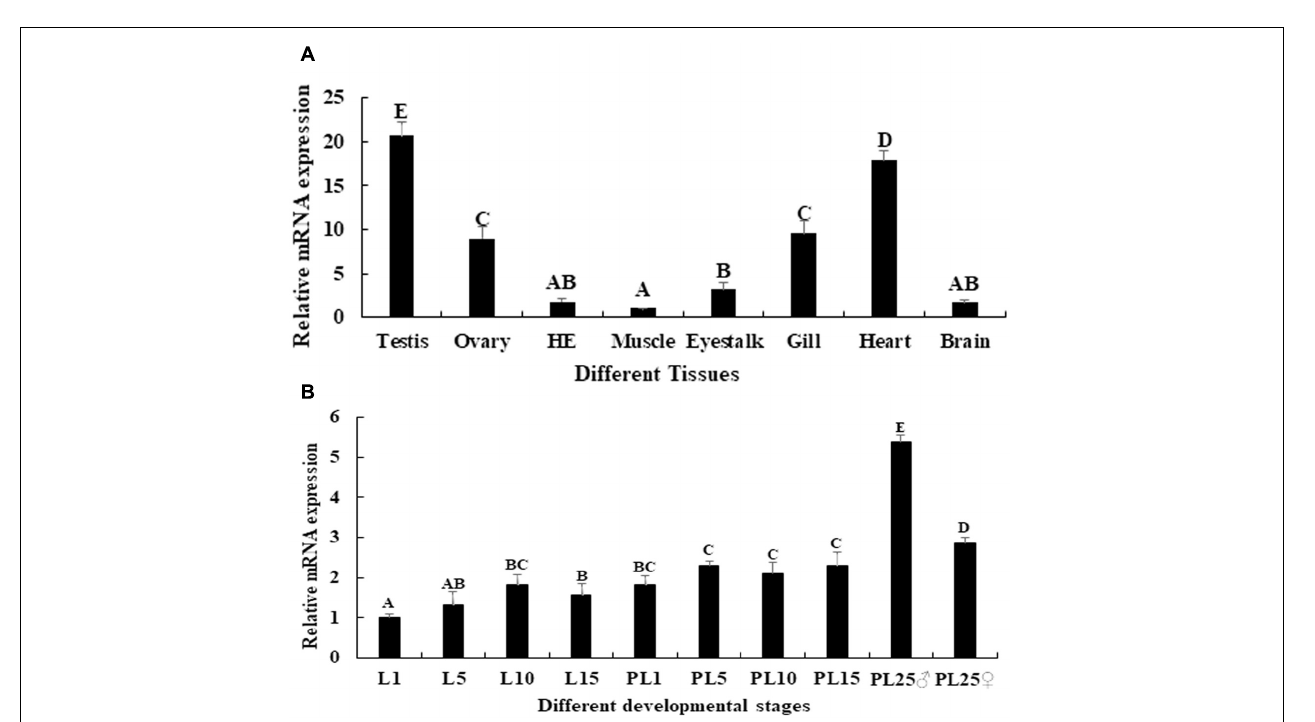
FIGURE 3 | The phylogenetic tree of SDHB from different organisms based on amino acid sequence comparisons. Species names of SDHB are listed on the right of the tree. Red rectangles indicated M. nipponense .